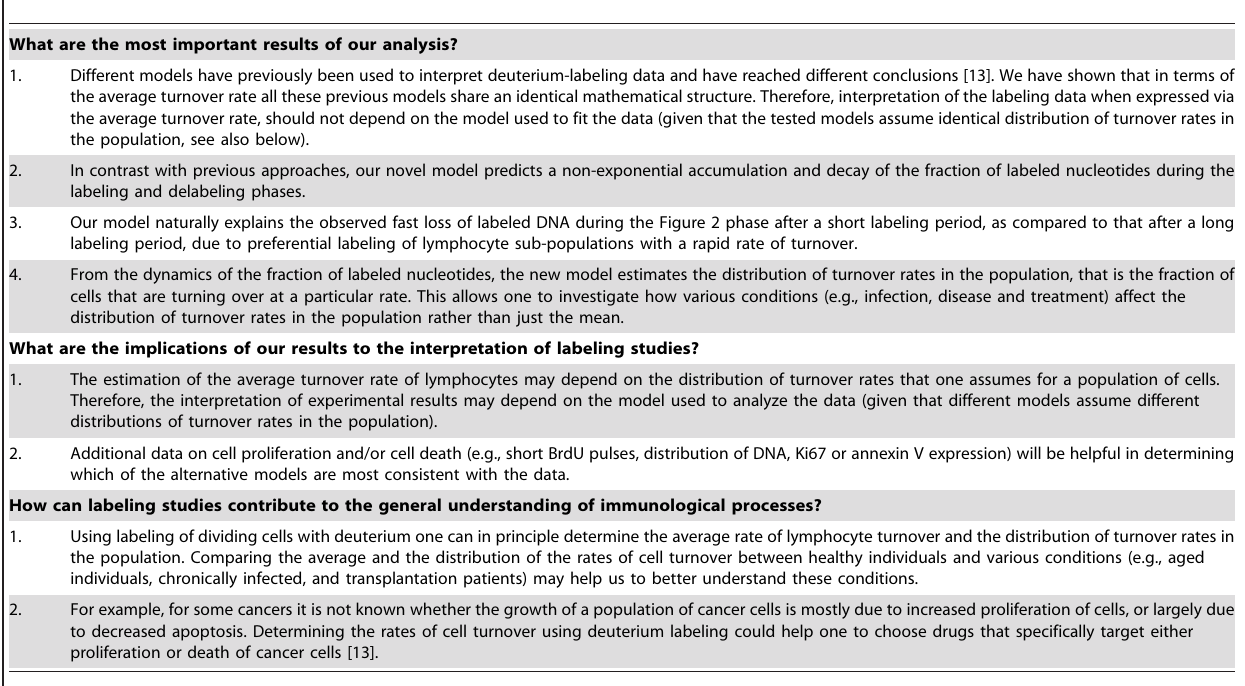
Table 1. Summary of the major findings of the